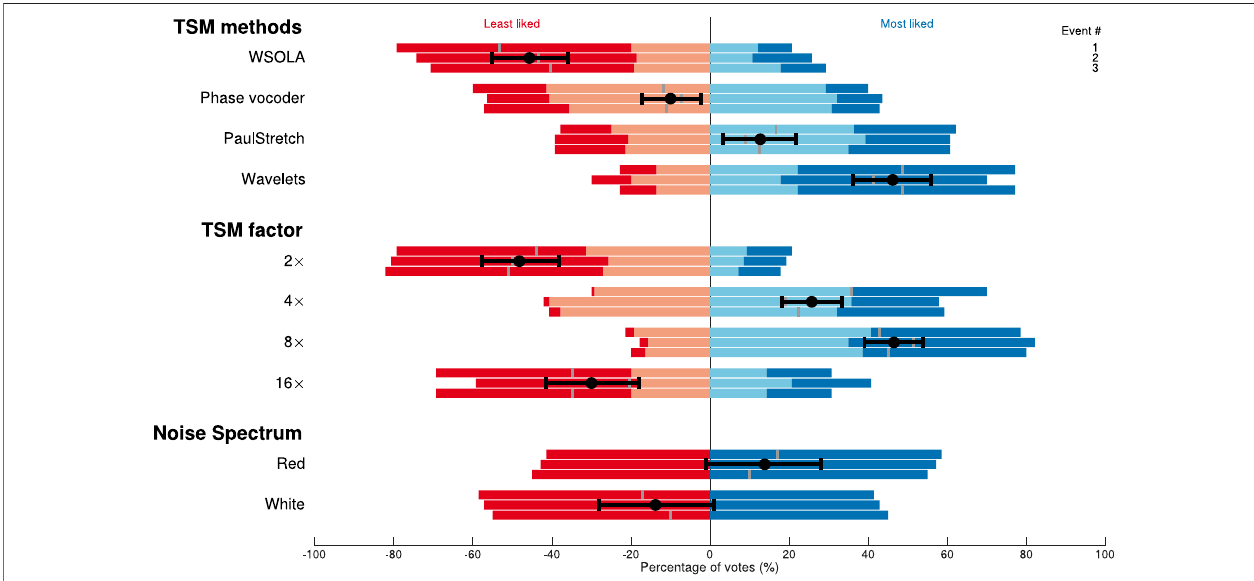
FIGURE 8 | Quantitative results of the survey. Stacked bars show the proportions of each ranking from least liked (dark red, far left) to most liked (dark blue, far right). The score for each audio clip is indicated by the grey bars, with the overall score across all 3 clips for each group shown as the black marker along with its 95% con fi denceinterval.NotethatforTSMmethodsandTSMfactorstherewerefourpossibleoptions,andthusalsofourpossibleranks,whilefornoisespectrumtherewere only two.